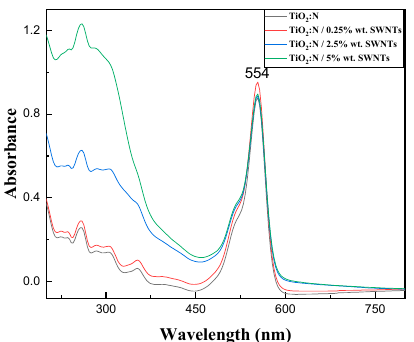
Figure 8. UV–VIS absorption spectra of the T and S1–S3 samples dispersed in an RhB aqueous solution in dark conditions, i.e., before to exposure to UV light.